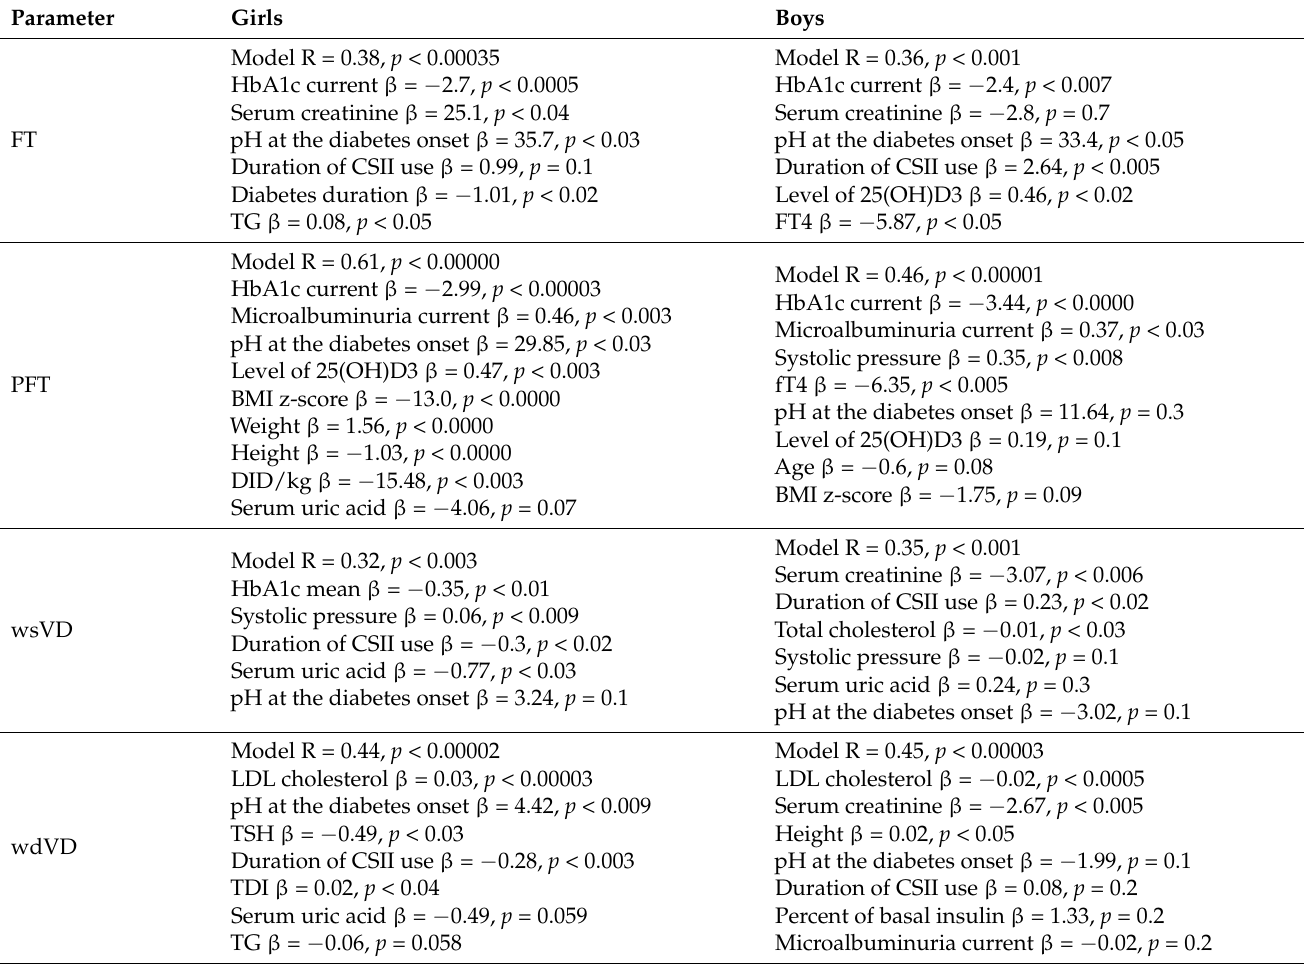
Table 2. Comparison of multiple regression models for boys and girls for different OCT